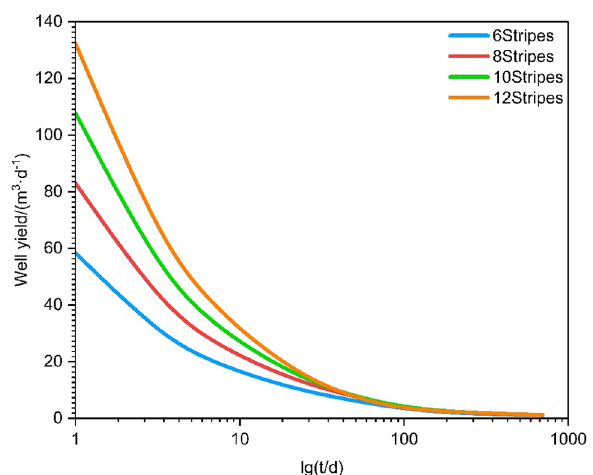
Fig. 9 Well production curves with different fracture numbers